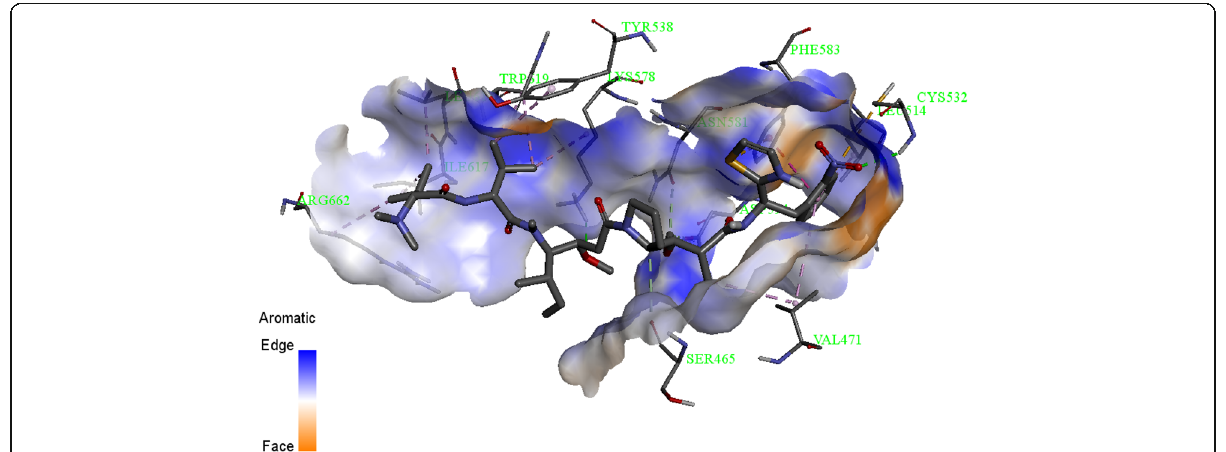
Fig. 7 3D diagram of the interaction between N3 with